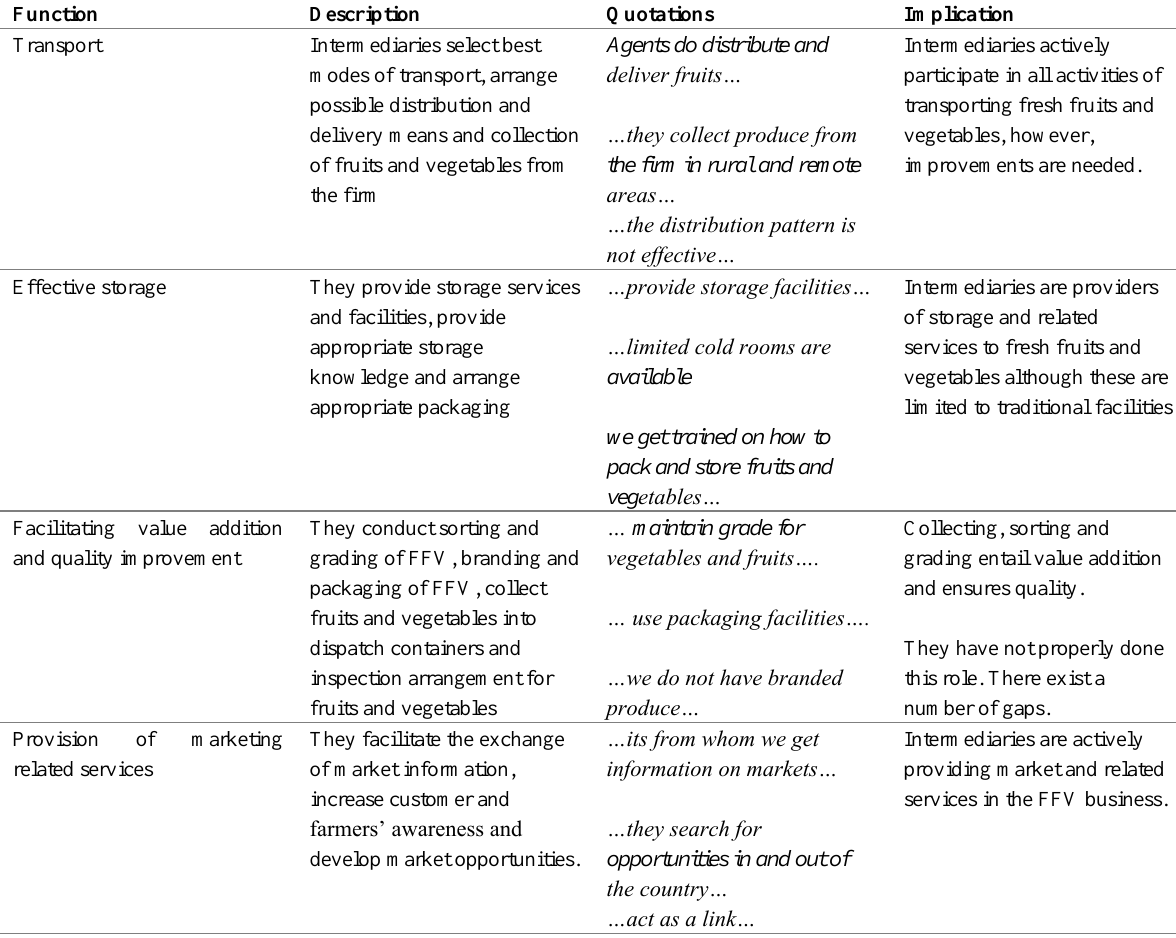
Table 1: Salient Roles Taken by Intermediaries in the Fresh Fruits and Vegetable Supply